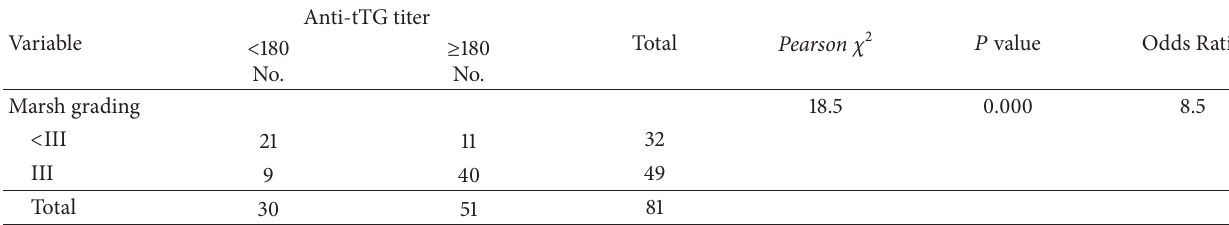
Table 3: Association between Marsh grading and tTG titer.